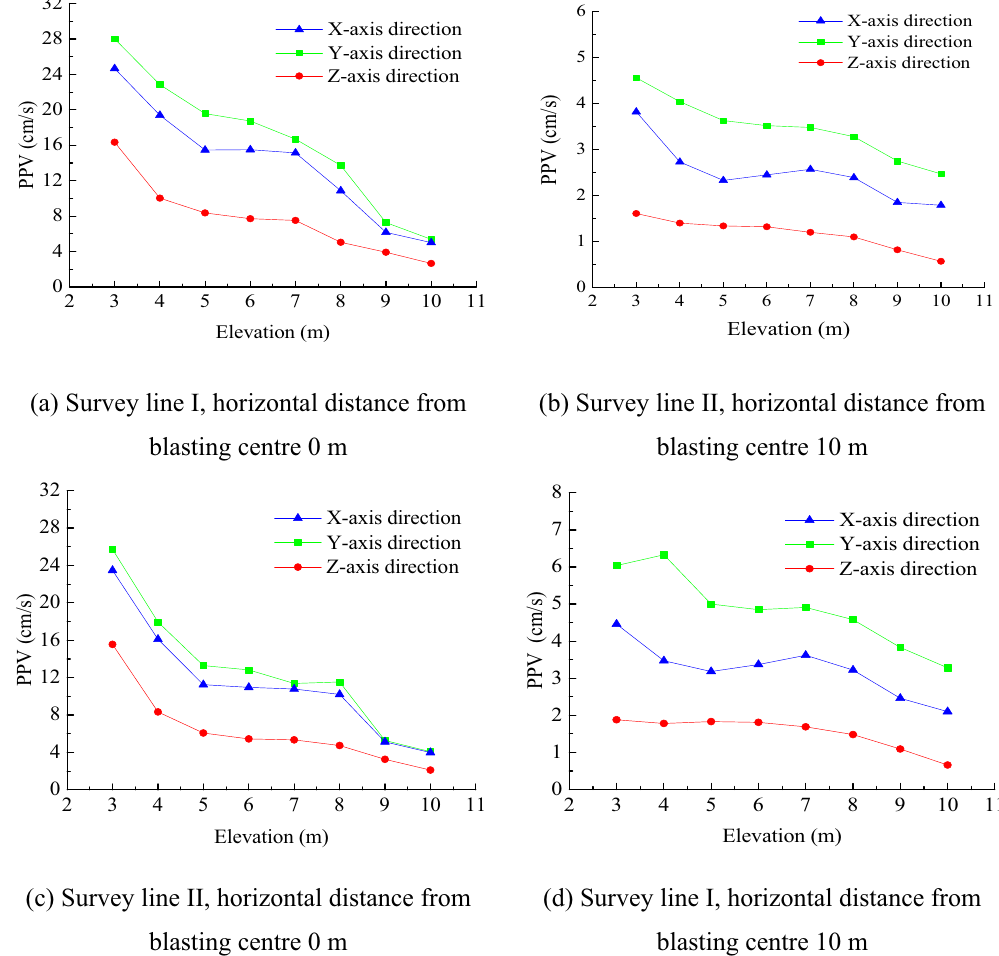
Figure 4. Variation of the measured sidewall PPV with elevation